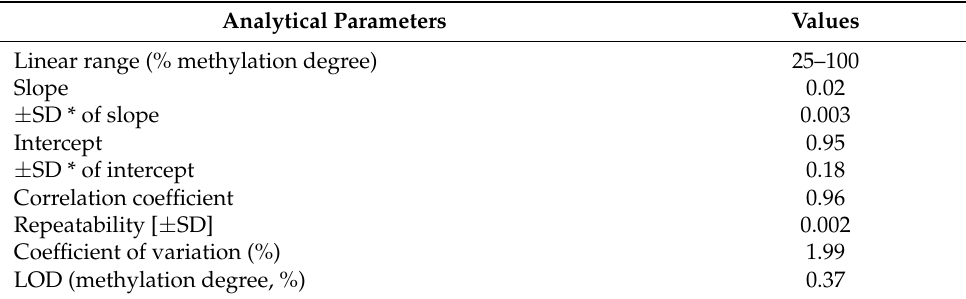
Table 2. Analytical features of the sensing system.